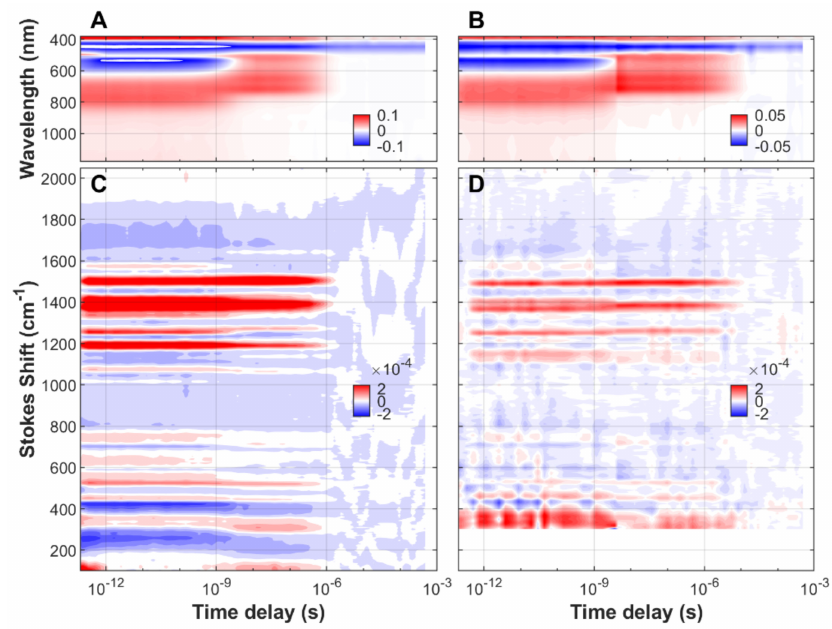
Figure 2. Time-resolved sub-picosecond to sub-millisecond Raman/absorption of FMN bound to EL222-WT upon excitation with a 475 nm actinic pump. ( A ) TA spectroscopy in H 2 O-based buffer. ( B ) TA spectroscopy in D 2 O-based buffer. ( C ) Transient FSRS in H 2 O-based buffer. ( D ) Transient FSRS in D 2 O-based buffer. Other parameters are as in Figure